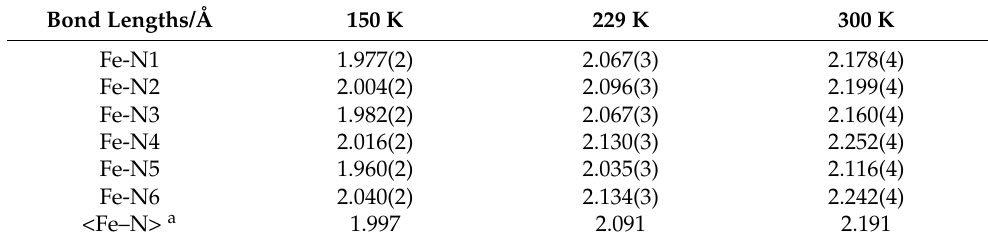
Figure 2. Asymmetric unit of Compound 1 at 150 K with thermal ellipsoids at 50% probability. Color code: Fe, dark green; S, yellow; N blue; F, green; C, gray; O, red; B, brown; H, light blue. Table 1. Bond lengths of Fe-N for [Fe(Abtz) 3 ] 2+ at 150, 229 and 300 K. Bond Lengths/Å